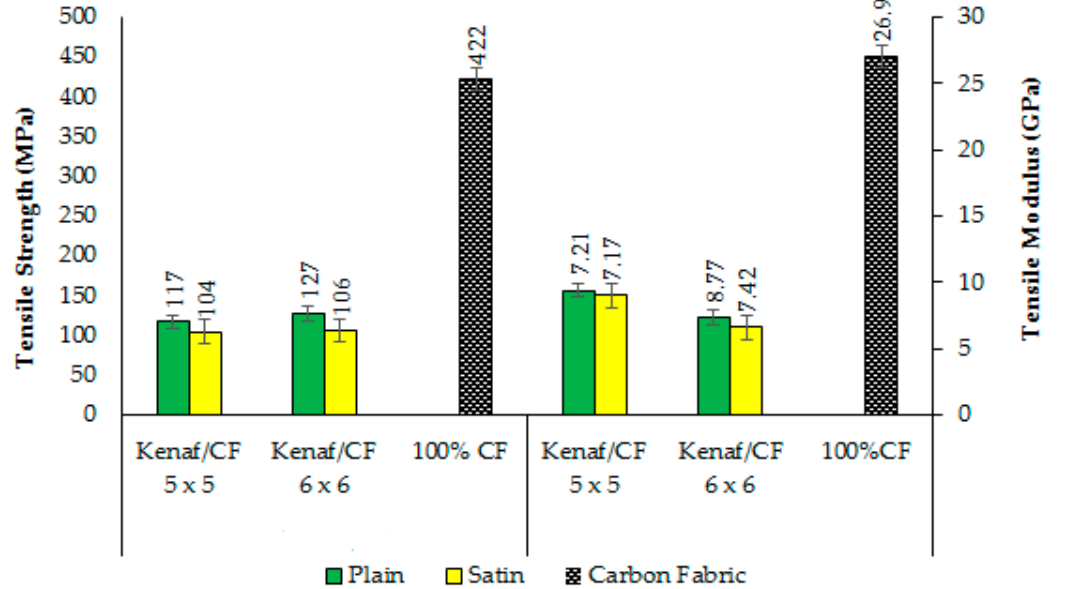
Figure 3. Tensile strength and tensile modulus of woven kenaf/carbon fibre hybrid composite.